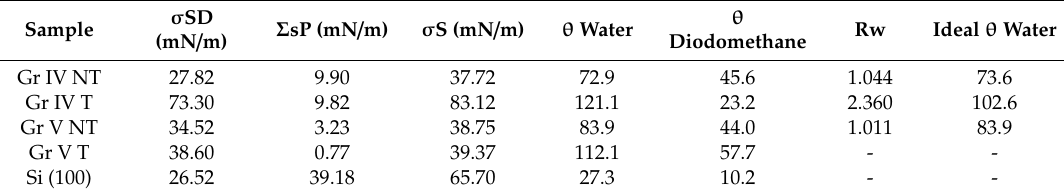
Table 8. Surface tensions and contact angles of the original samples. (GR IV: Titanium grade IV; GR V: Titanium grade V; T: SLA treated; NT: SLA non-treated).